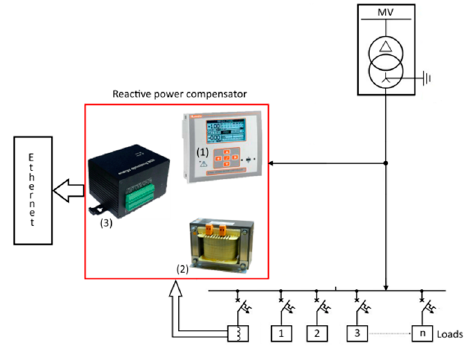
Figure 8. Schematic diagram of the applied reactive power compensation system.